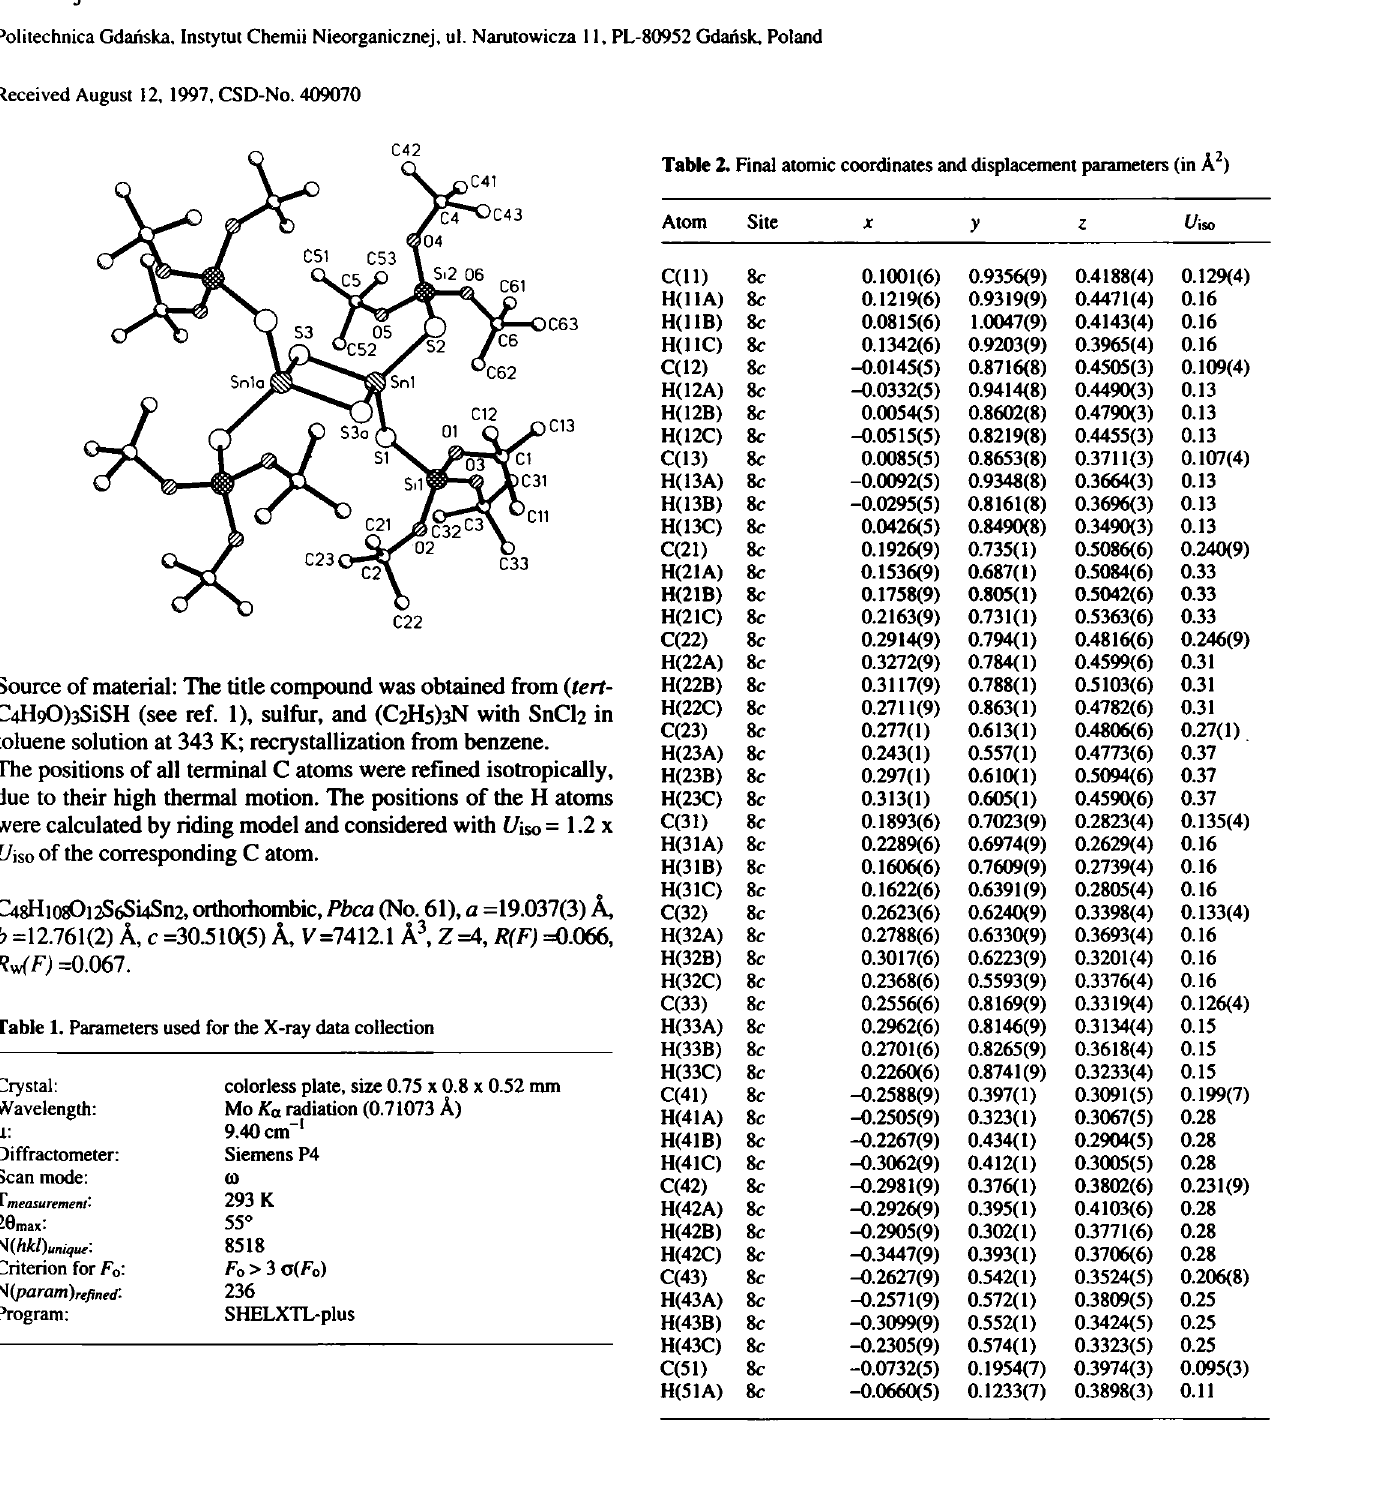
Table 2. Final atomic coordinates and displacement parameters (in